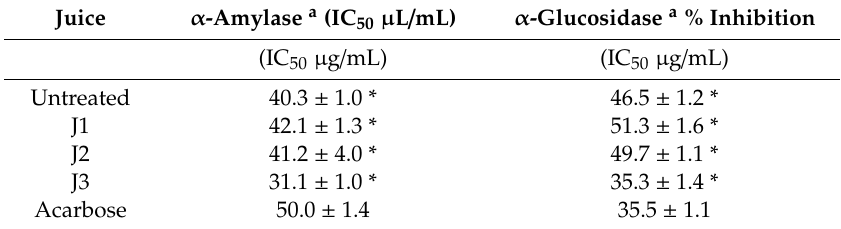
Table 4. Hypoglycemic activity of untreated and UF C. limon